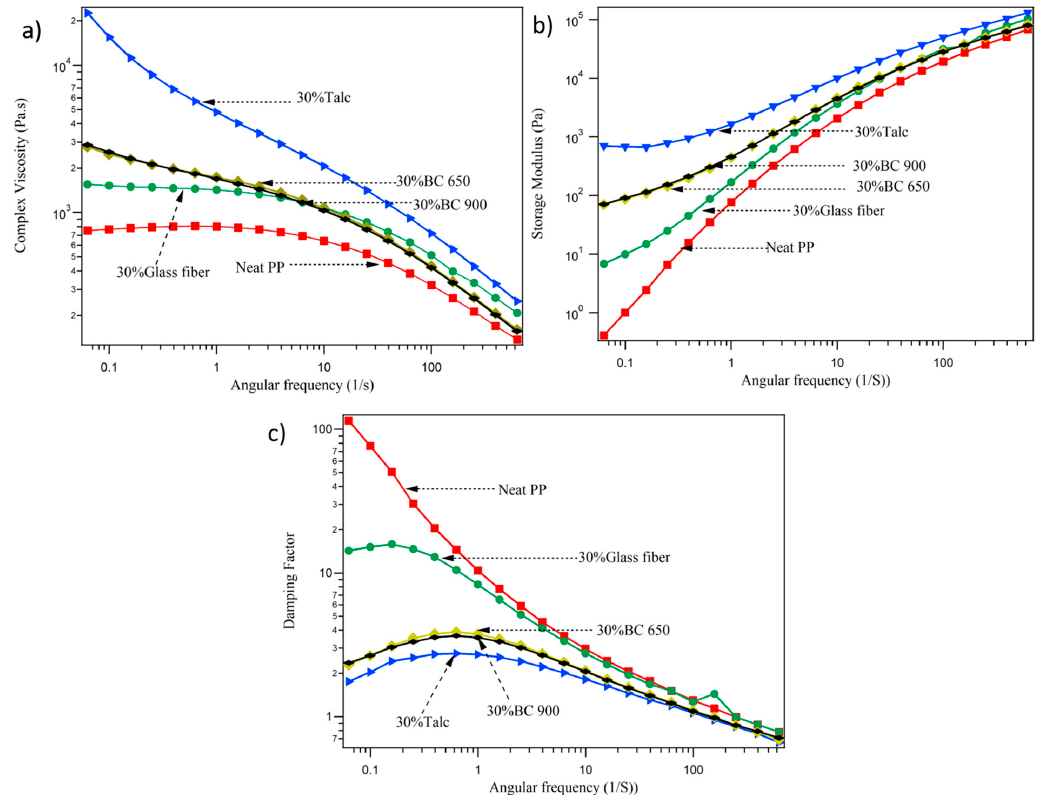
Figure 5. ( a ) Complex viscosity, ( b ) storage modulus, and ( c ) damping factor of PP-filler